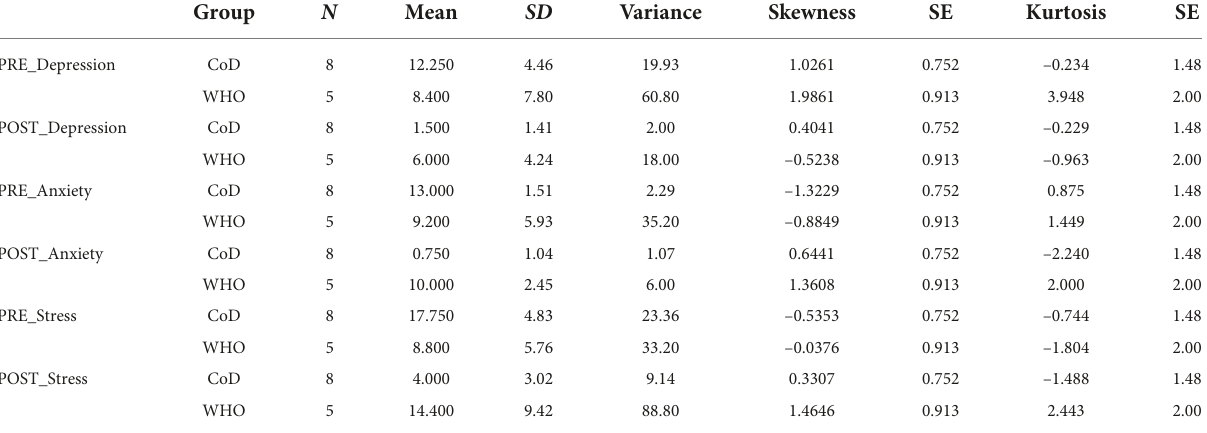
TABLE 2 DASS questionnaire items descriptives.